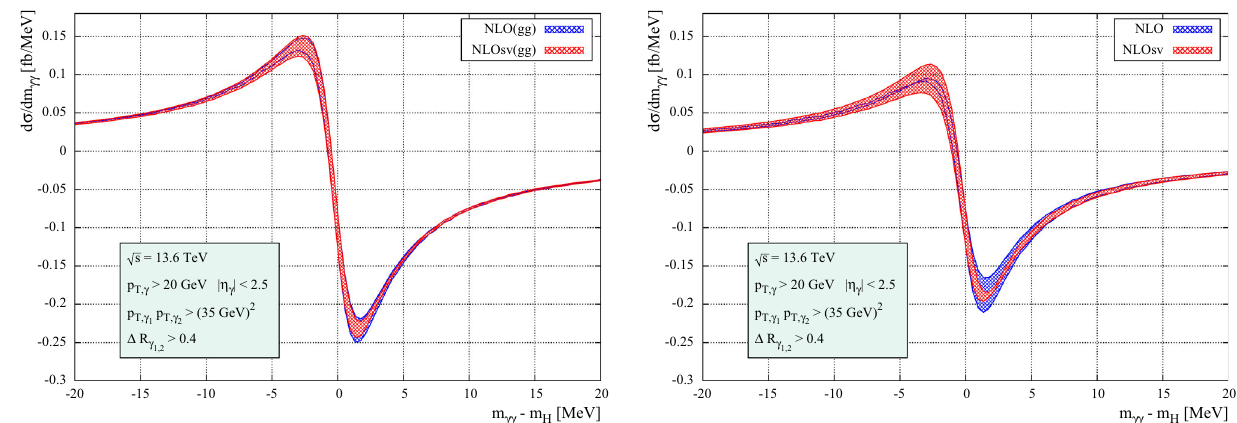
Fig. 3 Left pane: comparison of the exact NLO calculation and the soft-virtual approximation in the gg channel. Right pane: complete NLO prediction, inclusive of all channels, compared to the corresponding soft-virtual approximation